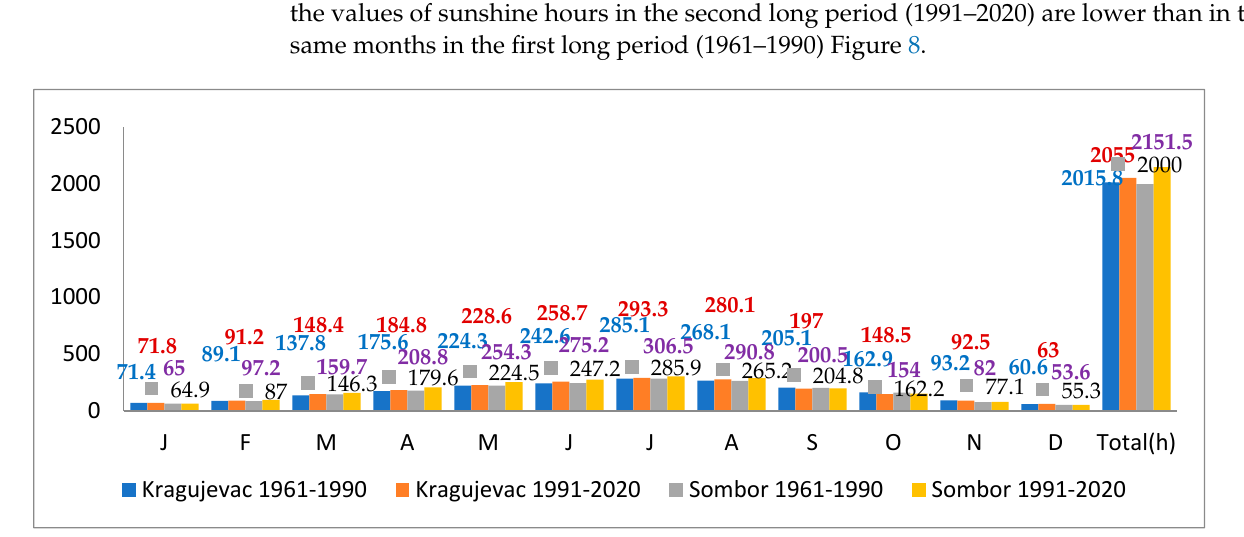
Figure 8. Average annual per monthly values of sunshine and total yearly average of sunshine in Kragujevac and Sombor for a period of time 1961–1990 and 1991–2020. Source: RHMS-Meteorological yearbooks.